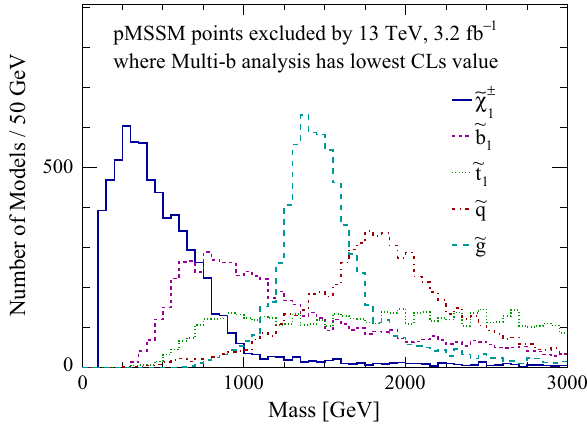
Fig. 3 Distribution of sparticle masses for the excluded points where the Multi-b analysis is most sensitive. The lines correspond to the chargino ˜ χ ± ( blue solid ), lightest sbottom ˜ b 1 ( magenta short-dashed ), 1 lightest stop ˜ t 1 ( green dotted ), lightest squark ˜ q ( red dot-dashed ) and gluino ˜ g ( light blue long-dashed )